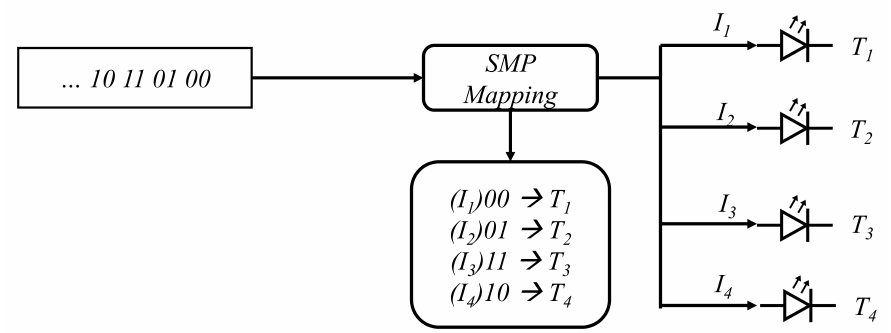
Figure 7. SMP example for MIMO communication four antenna configurations